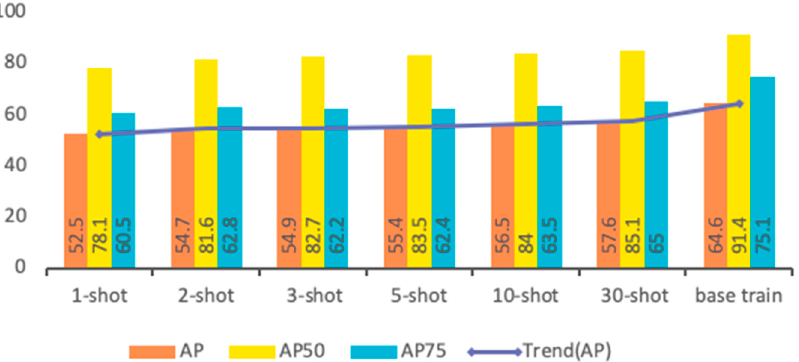
Figure 7. Comparison of AP, AP50, and AP75 between n -shot fine-tuning and base classes of train- ing.